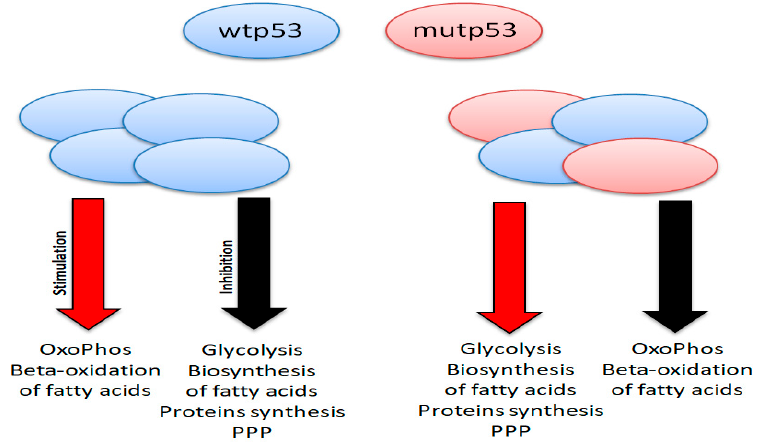
Figure 8. Opposite functions on cancer metabolism of wt (wild-type) p53 and mut (mutant) p53.